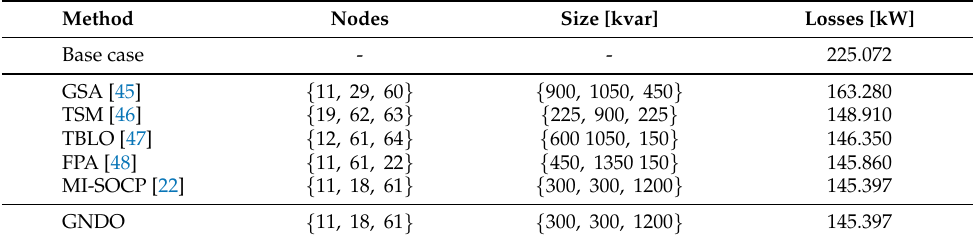
Table 6. Optimal location of fixed-step capacitor banks in the IEEE 69-bus